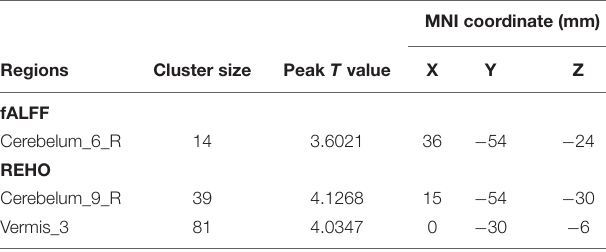
TABLE 1 | Brain regions with longitudinal fALFF and ReHo